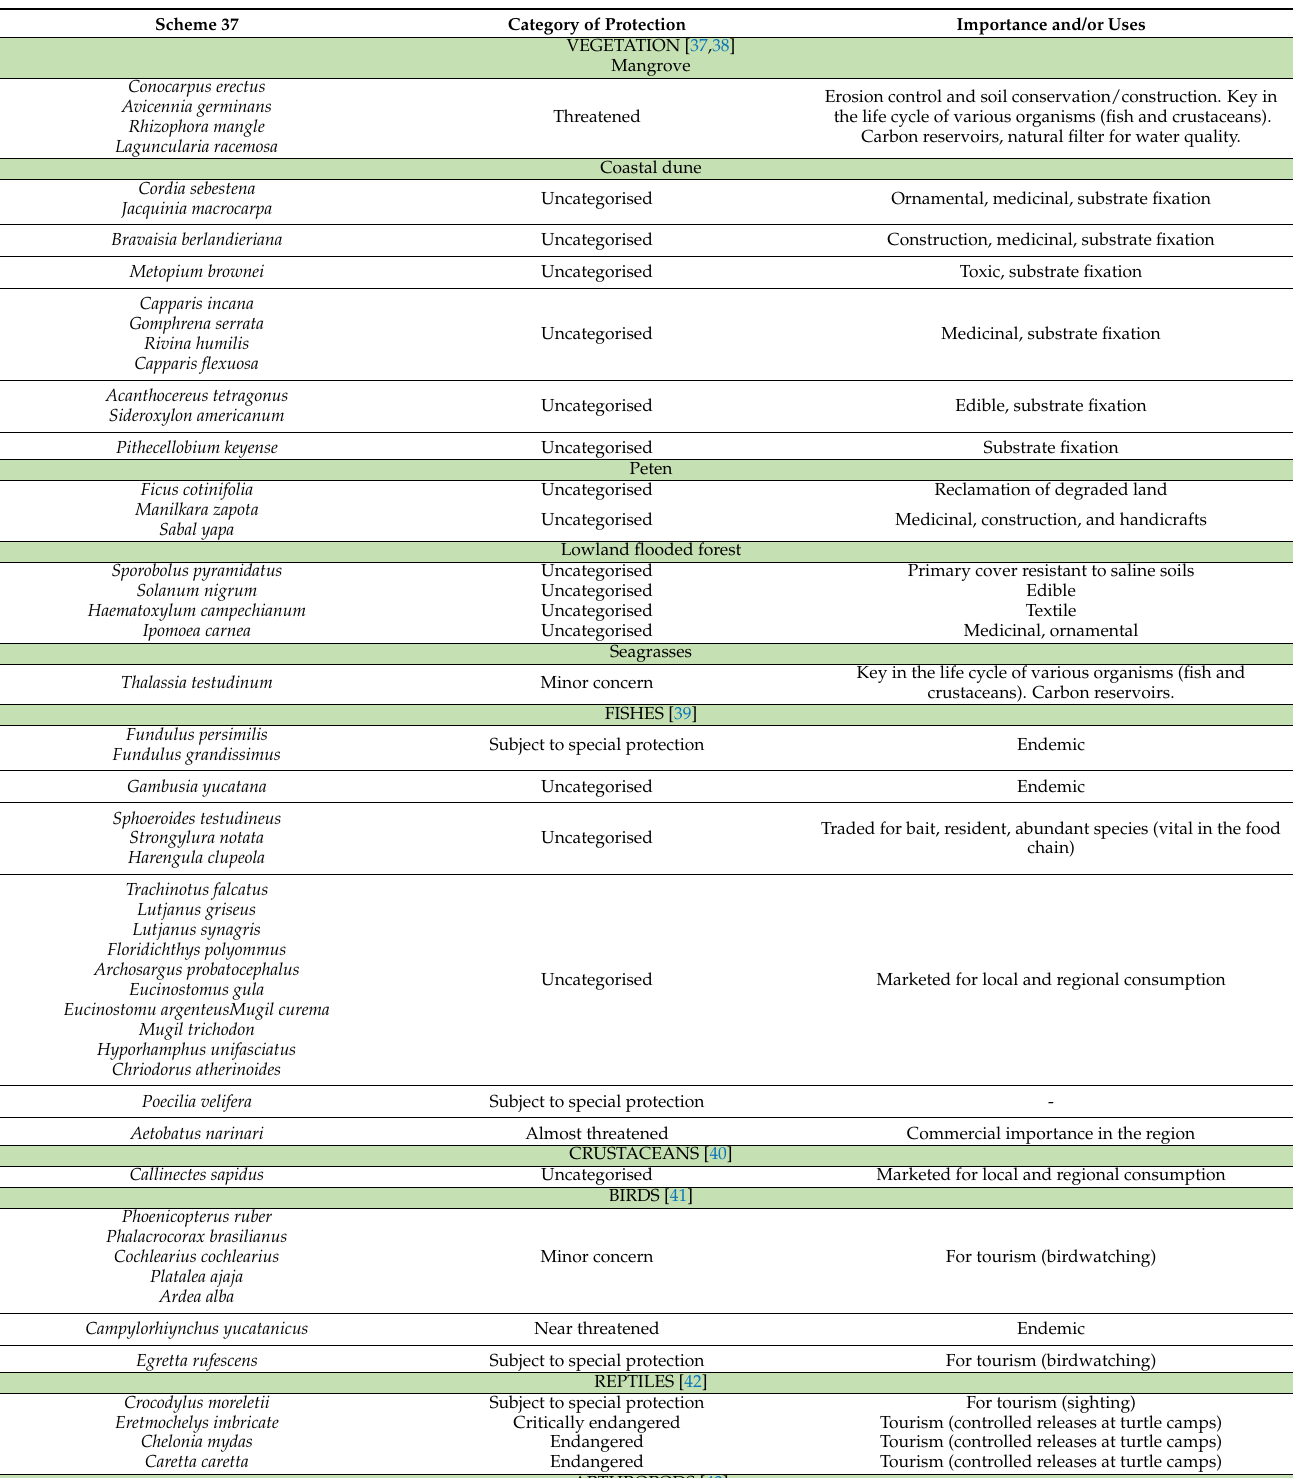
Table 1. Species reported in the north of Yucatan, detailing their ecological and commercial importance, anthropic uses, and protection